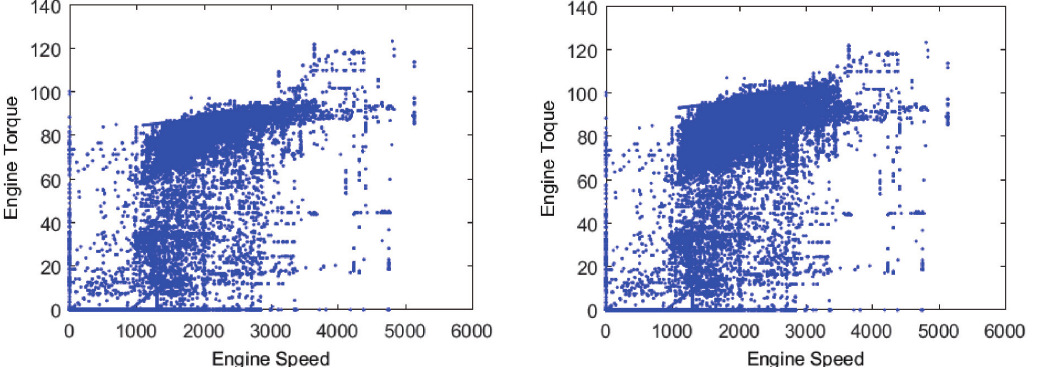
Figure 7. Engine operating points from the benchmark test ( left ) and the simulation ( right